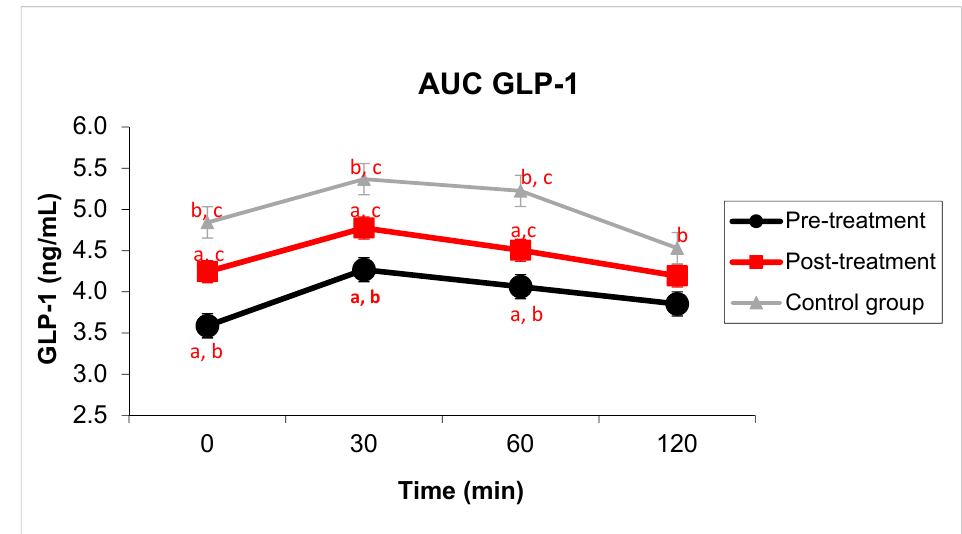
Figure 1. Changes in Glucagon-like peptide-1 (GLP-1) levels after antibiotic therapy compared to the control group. GLP-1 levels in H. pylori -infected patients at baseline and after 75g-OGTT and after 2 months of post-antibiotic treatment compared to the control group. Student’s t -test for paired samples and Student’s t -test between independent samples were used to compare the group of H. pylori -infected patients before and after antibiotic treatment, and control group, respectively. Equal letter means differences between groups. a : differences between H. pylori -infected individuals before and after antibiotic treatment, p < 0.05. b : differences between H. pylori -infected patients and the control group, p < 0.05. c : differences in patients undergoing antibiotic therapy compared to the control group, p < 0.05.